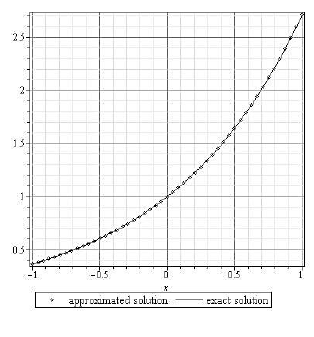
Figure 1. Exact and approximated solutions of Example 4 ( k = 7).